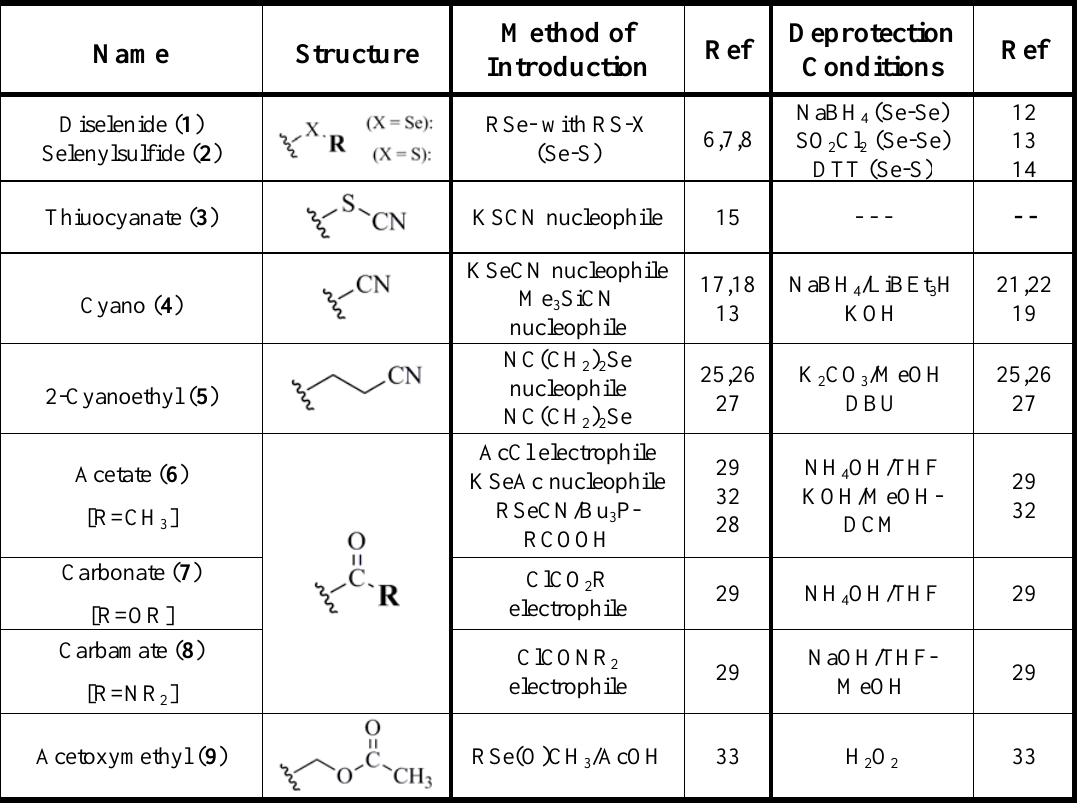
Table 1. Known selenol protection